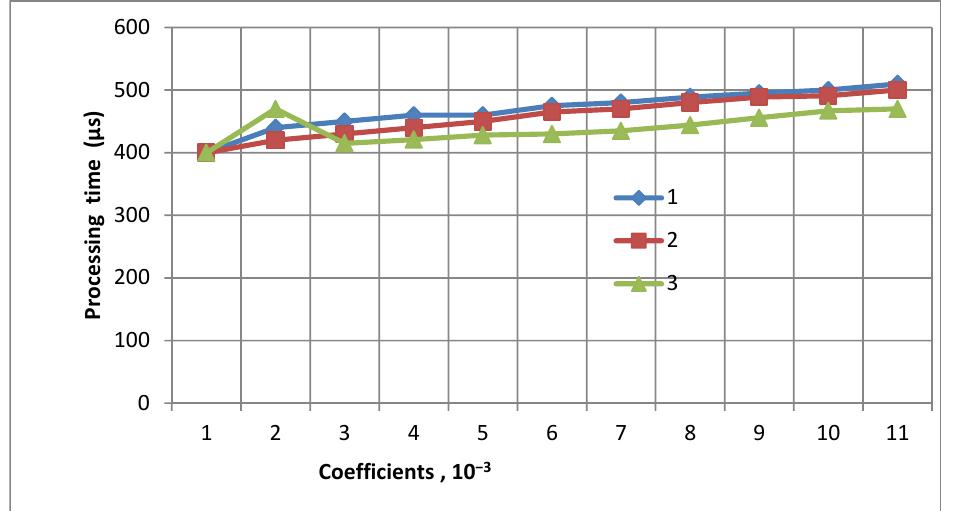
Figure 11. The dependence of the processing time of the calculations of the matrix of rank 120 on the coefficient of regularization of predictions (curve 1), the coefficient of initial learning (curve 2) and the coefficient of learning speed (curve 3).